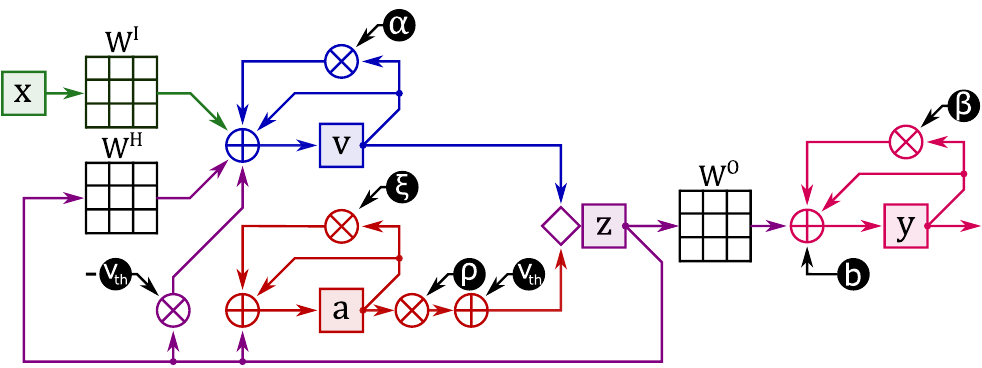
Figure 6. Flowchart of the LSNN update cycle. Neuron variables are represented with rectangles. Simple mathematical operations are represented with circles. Matrix multiplication operations with synaptic weights are represented by grids. Constants are represented with black circles. Data movements are represented by arrows between operators and